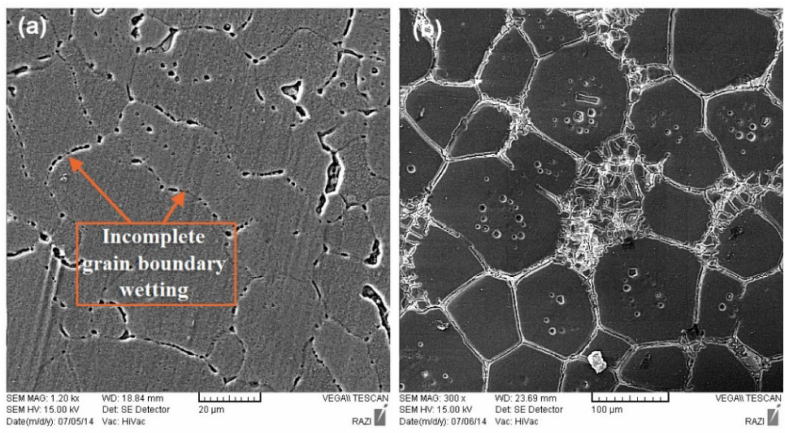
Figure 4. SEM images of 20% compressed 7075 alloy heat treated at 600 ˝ C for ( a ) 10 min; ( b ) 35